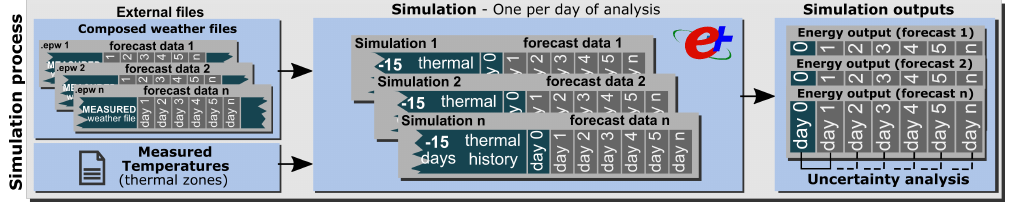
Figure 3. Simulation process